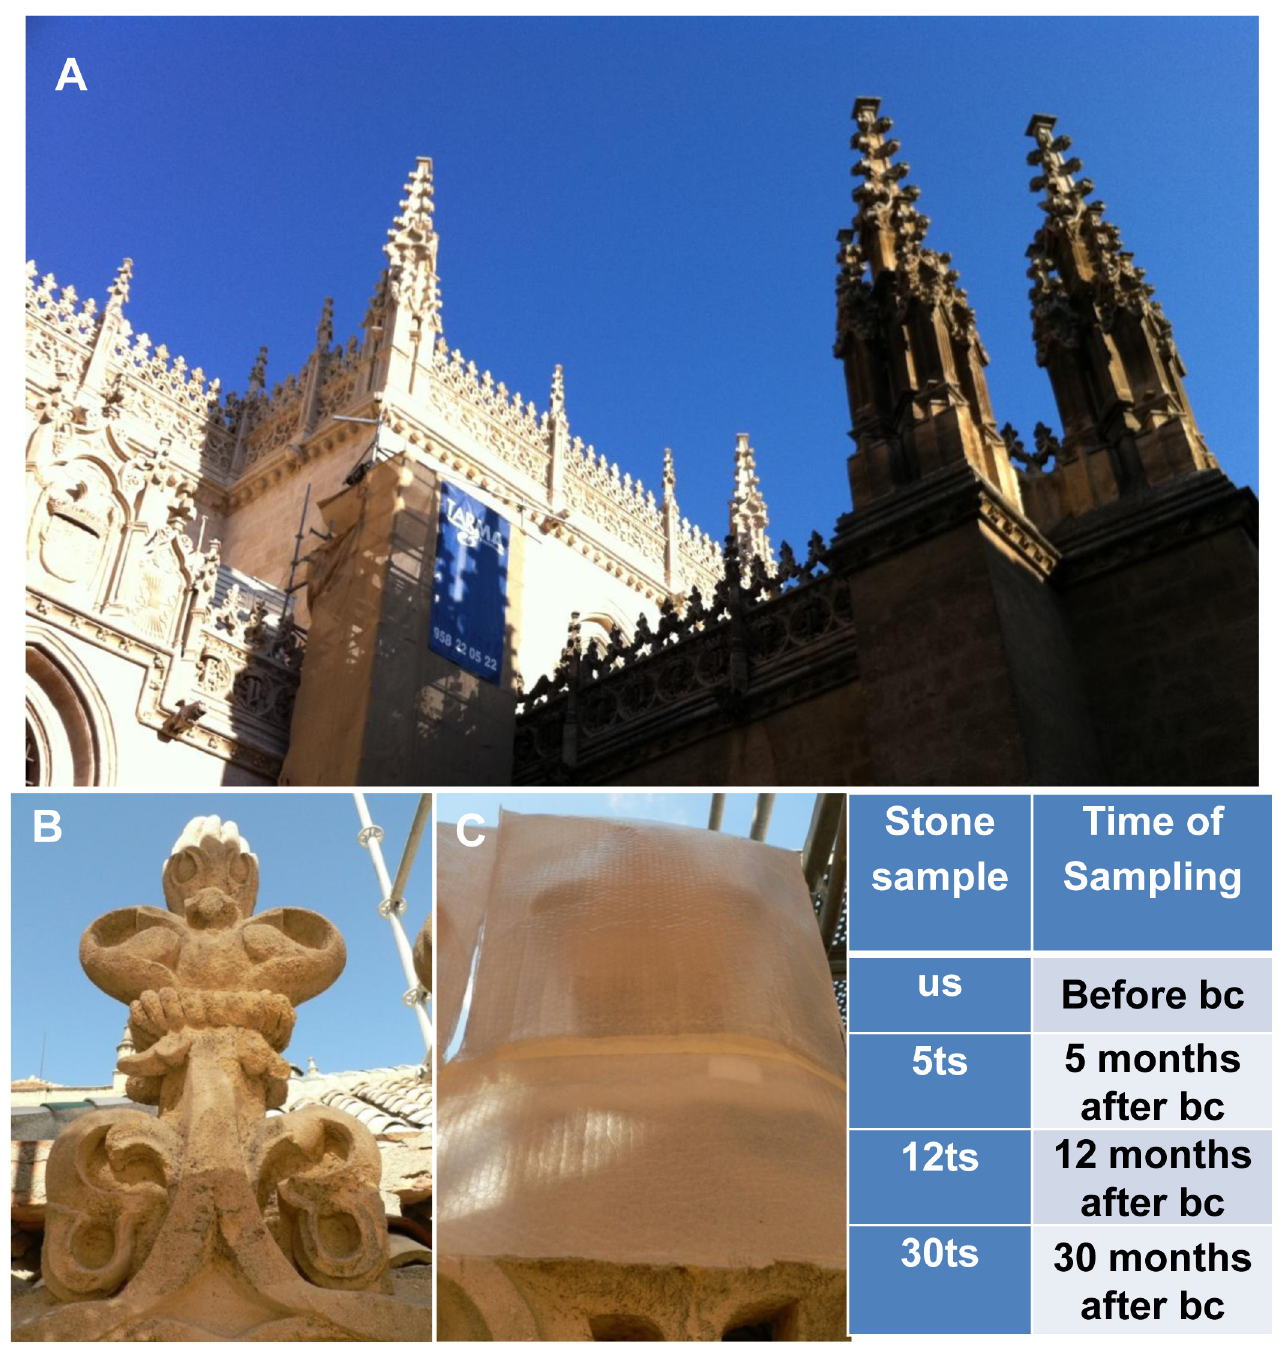
Fig 1. Treatment application on calcarenite crestings at the Royal Chapel of Granada. A) General view of the cresting elements; B) Detail of a weathered cresting element; C) Element covered by a protecting foil during treatment. The table shows the samples name and the sampling times. us: Untreated stone; 5ts: Five months after the bio-consolidation treatment; 12ts: Twelve months after the bio-consolidation treatment; 30ts: Thirty months after the bio-consolidation treatment; bc: Bio-consolidation treatment. With permission from Fadwa Jroundi, original copyright (2015).